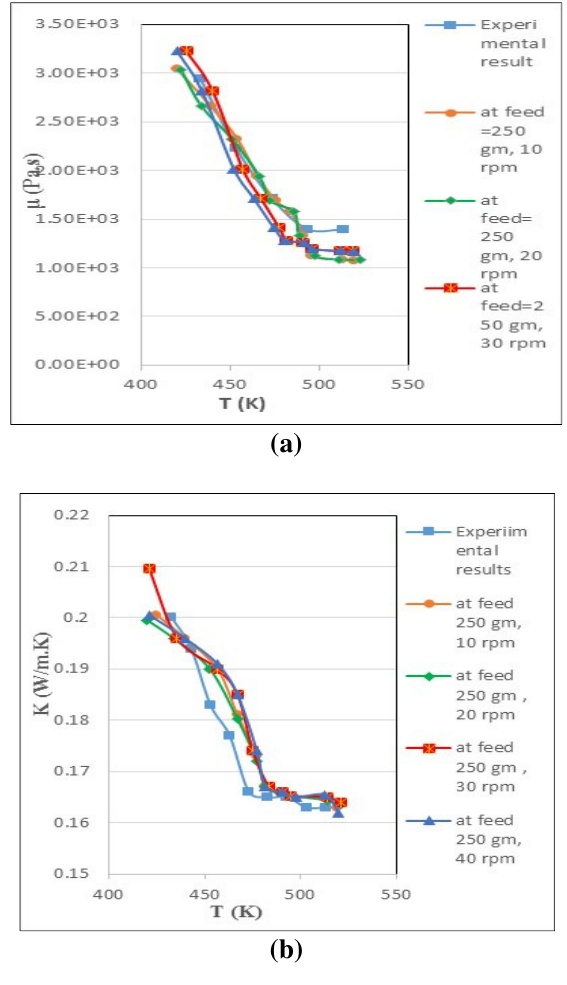
Fig. 13. Specific heat Contour plane at 500